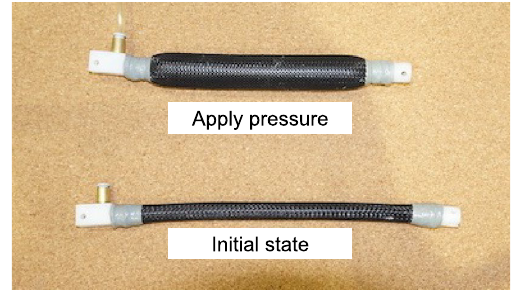
Fig. 1 Overview of McKibben pneumatic actuator: MPA (bottom) before and (top) after the application of air pressure